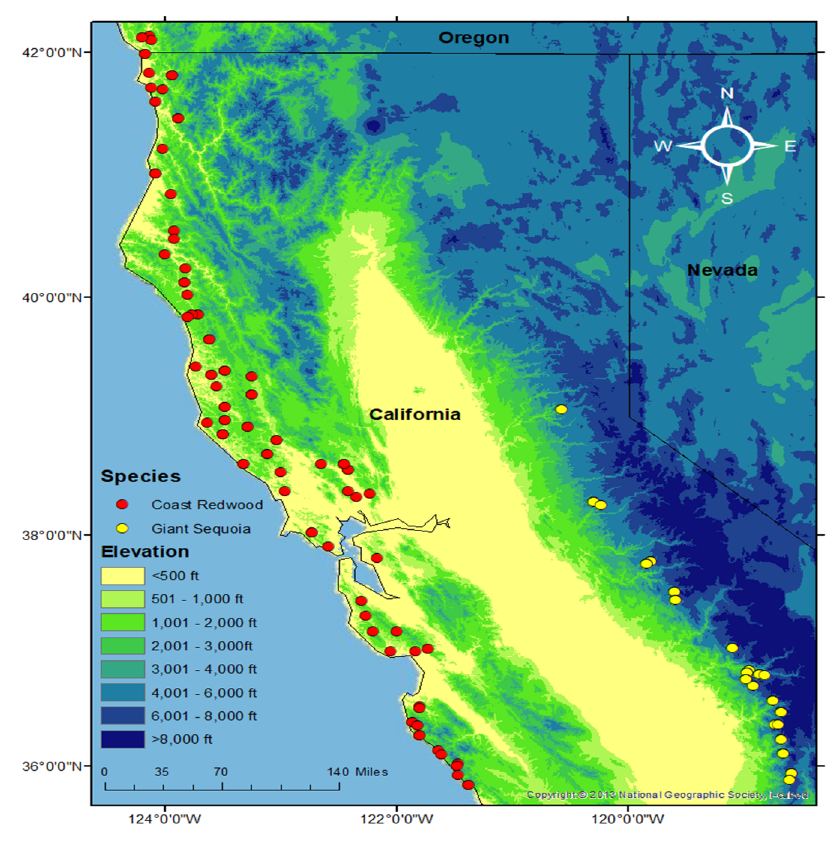
Figure 1. Sampling distribution of coast redwood and giant sequoia .